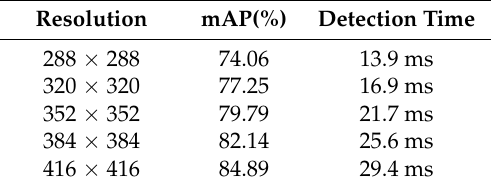
Table 7. Influence of different resolutions on performance.